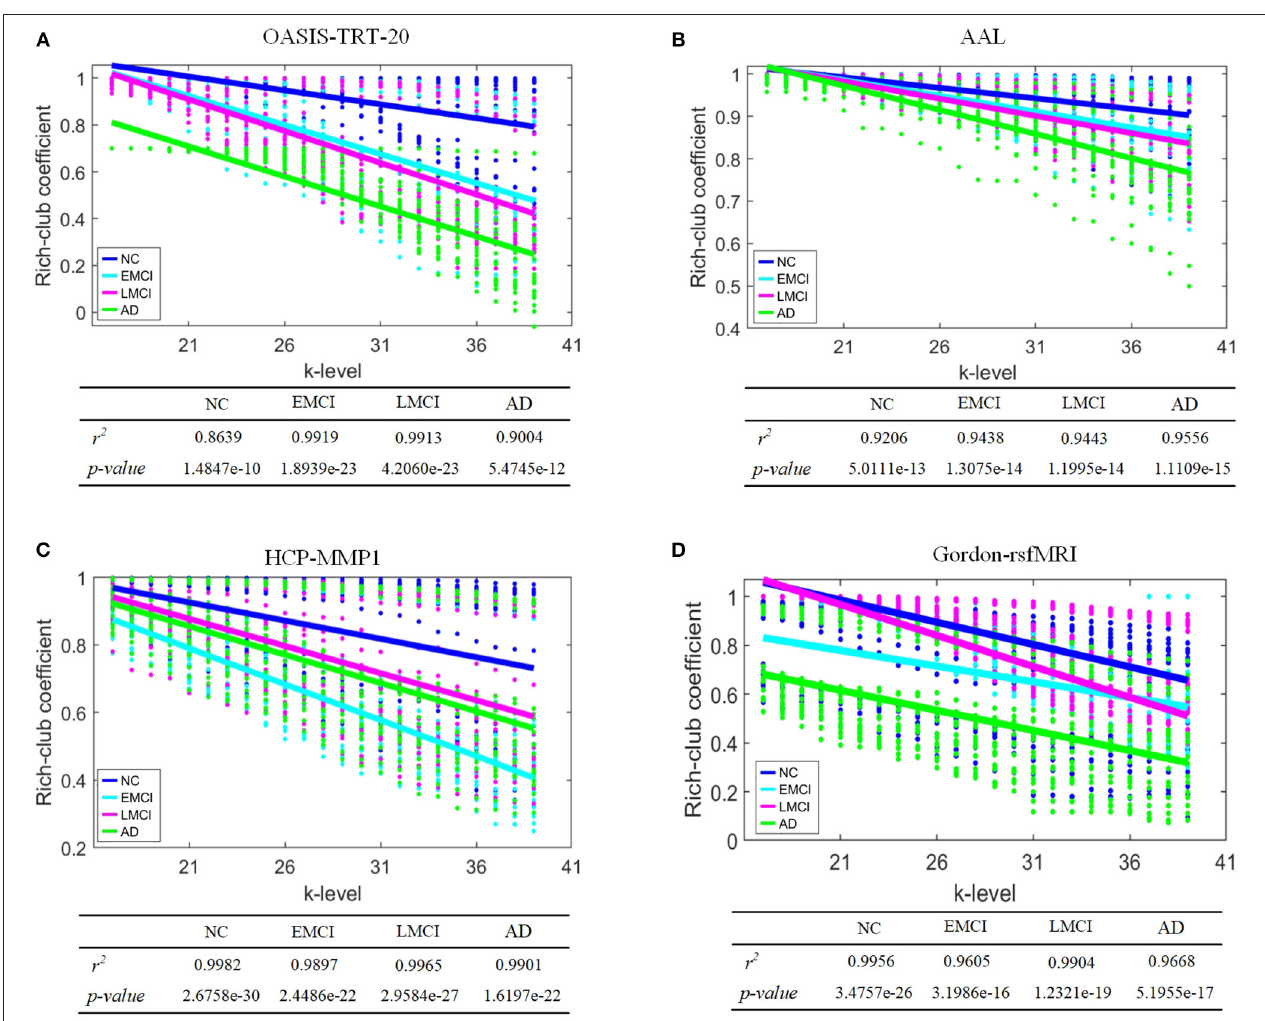
FIGURE 5 | Linear regression of rich-club coefficient over a range of k -level from 17 to 39. NC, EMCI, LMCI, and AD groups are represented by blue, cyan, magenta, and green colors, respectively. (A) OASIS-TRT-20, (B) AAL, (C) HCP-MMP, and (D)